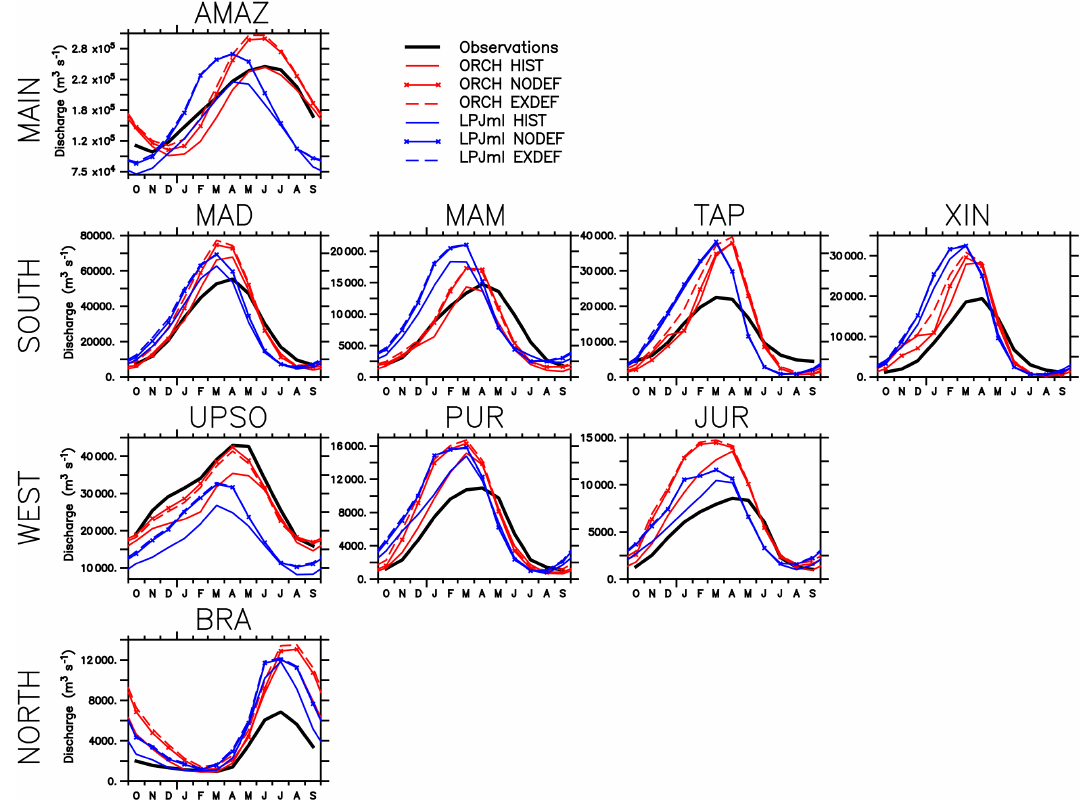
Figure 12. Seasonal river discharge (m 3 s − 1 ) simulated by ORCHIDEE and LPJmL-DGVM from HIST (averaged over 1970–2008) and from NODEF and EXDEF LCC scenarios (mean of the three GCM forcings for each scenario averaged over 2080–2099) at the gauging stations over the Amazon catchments (the abbreviations of the catchments are indicated in Table S1). The results from HIST simulations are compared with the observations from the SO HYBAM (averaged over 1970–2008). River discharge is not represented for INLAND-DGVM because it does not include a routing